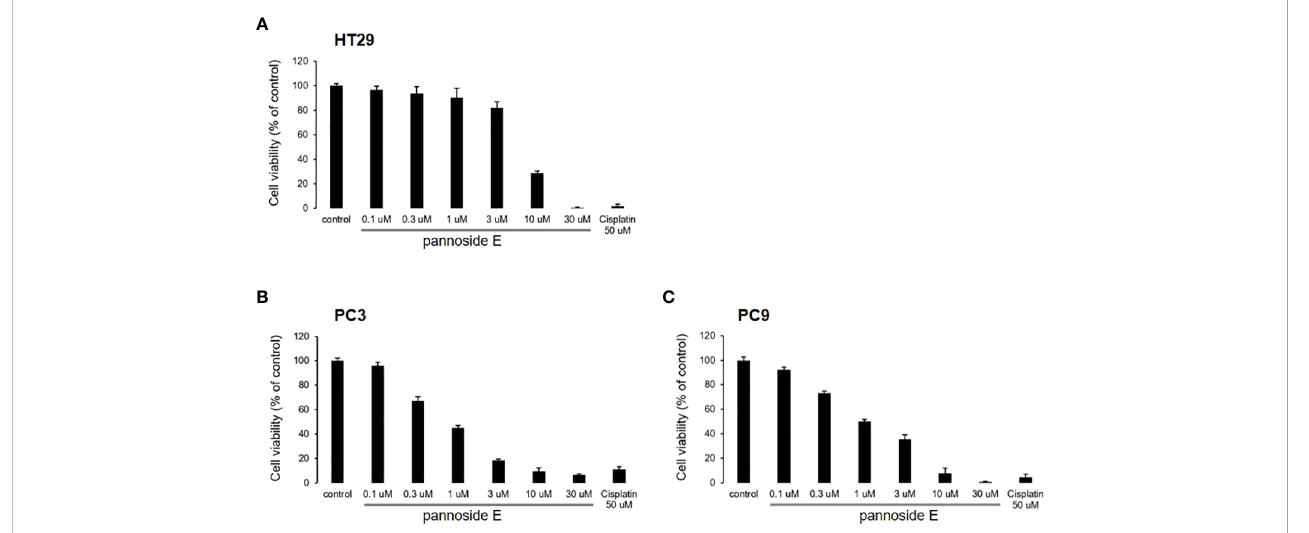
FIGURE 4 Effect of pannosides E on cell viability in HT29, PC3, PC9 cells. (A – C) HT29, PC3, PC9 cells were cultured with pannoside E for 72h. Cell viability was measured by absorbance at 490 nm (mean ± S.D., n =